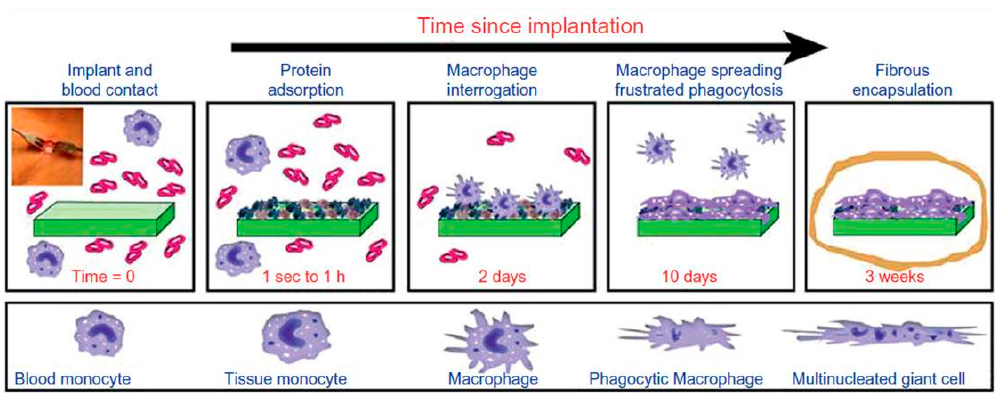
Figure 6. The in vivo composite reaction to synthetic biomaterials: timeline and monocyte/macrophage phenotypes. Adapted from [17], with permission from © 2015 Elsevier.